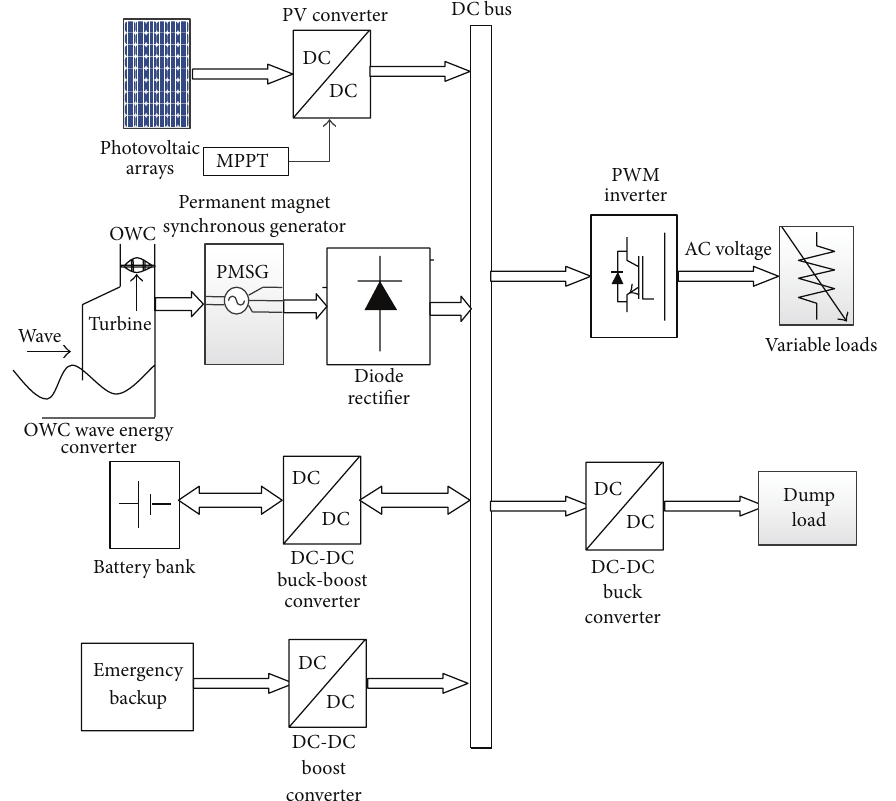
Figure 1: Block diagram of the proposed standalone PV-wave hybrid system.